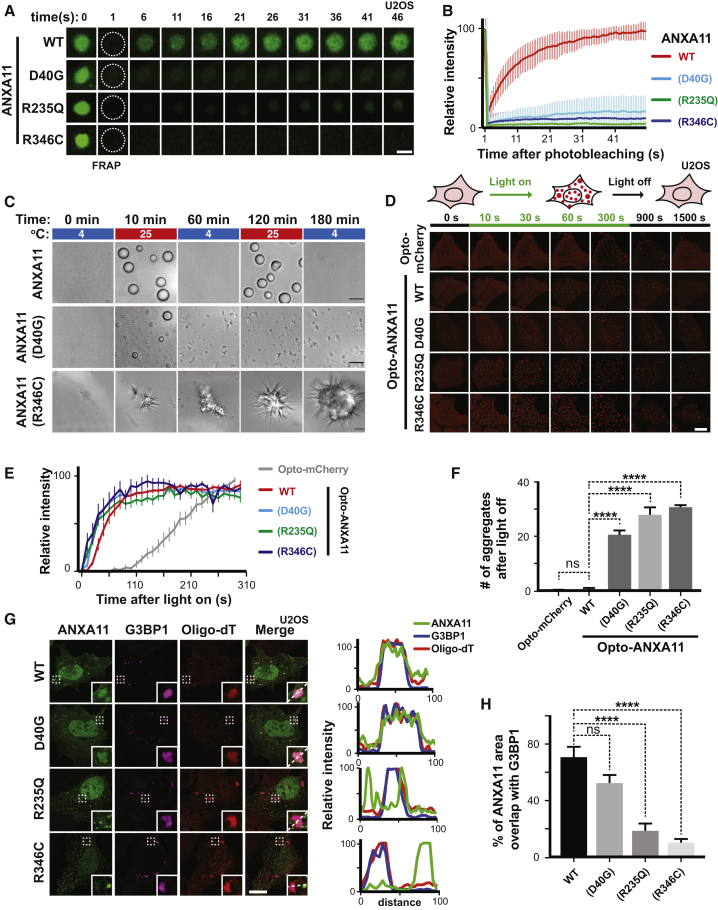
Effects of ALS-Associated ANXA11 Mutations on RNA Granule Interactions(A) U2OS cells expressing mEmerald-tagged ANXA11 (WT, D40G, R235Q or R346C) were heat shocked (43oC) for 30 minutes. A single ANXA11-positive puncta in each of the different transfected cells was photobleached and recovery of fluorescence was monitored by time-lapse imaging. Scale bar: 1 μm.(B) Quantification of the FRAP experiments in (A), n=21. Error bars = SEM.(C) Phase partitioning characteristics of ANXA11 ALS-associated mutants in vitro. Purified WT, D40G, R346C forms of ANXA11 were temperature transitioned between 4oC and 25oC through multiple cycles. ANXA11(p.D40G) formed both large spherical droplets and smaller, non-fusing gelled condensates, with the condensates unable to reform after one round of temperature shift (middle panel). ANXA11(p.R346C) formed irregularly-shaped solid and spiculated gelled condensates with few, if any, liquid droplets capable of disassembly/reassembly during temperature shifts (bottom panel). Scale bar: 5 μm.(D) U2OS cells expressing similar levels of Opto-mCherry (CRY2olig-mCherry), Opto-ANXA11 or Opto-ANXA11 ALS-associated mutant were exposed to 0.2% 488nm light to initiate oligomerization. Scale bar: 30 μm. See also Figure S4B.(E) Quantification of integrated fluorescence intensity of Opto-labeled proteins in (D) during 300 seconds of 488 nm light activation, n=20. Error bars = SEM. See also Figure S4C.(F) Quantification of the number of Opto-labeled puncta present 30 minutes after the 488 nm light was turned off. n=17-19. One-way ANOVA, ns, not significant. ∗∗∗∗p < 0.0001. Error bars= SEM.(G) Immunostaining of mEmerald-tagged wild-type and mutant ANXA11 with G3BP1 and mRNA labeled by Oligo-dT in U2OS cells following 30 minutes of heat shock. Co-localization of ANXA11 with individual RNA granules is plotted in the line scans to the right. Scale bar: 30 μm. See also Figure S4D.(H) Quantification of area of ANXA11 structures co-localizing with G3BP1-labeled RNA granules in (G). n=28-31. One-way ANOVA, ns, not significant. ∗∗∗∗p < 0.0001. Error bars = SEM.